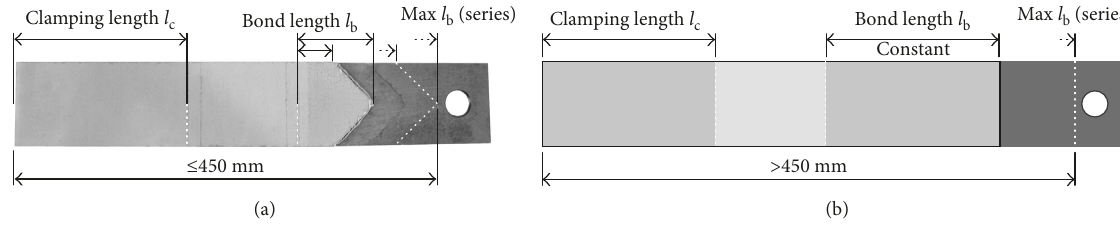
Figure 6: Variable bond length of adaptive pullout specimens. (a) Cone-shaped specimen and (b) rectangle-shaped specimen.